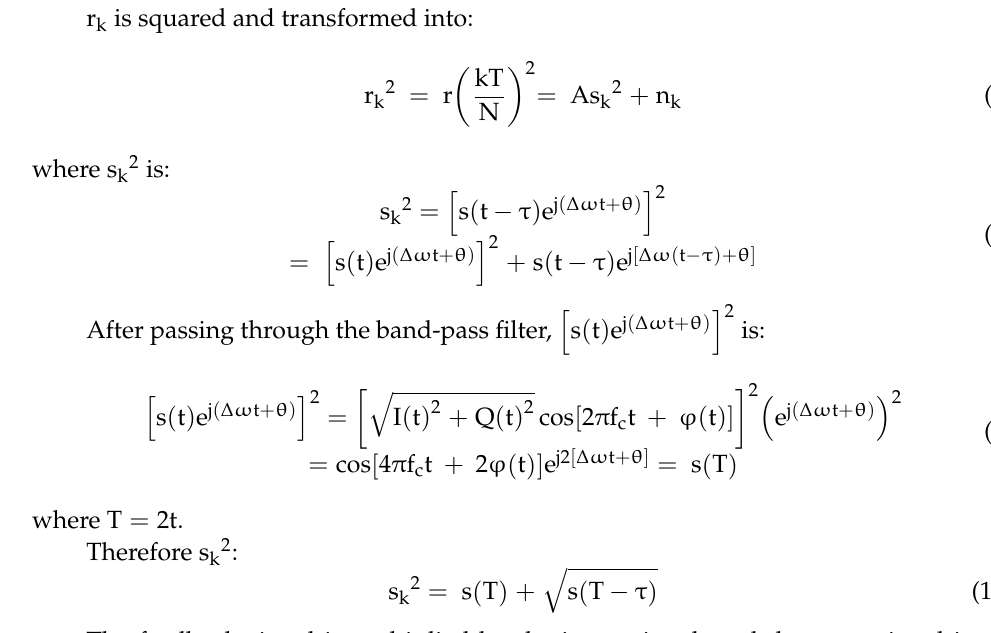
Figure 9. Schematic diagram of symbol timing